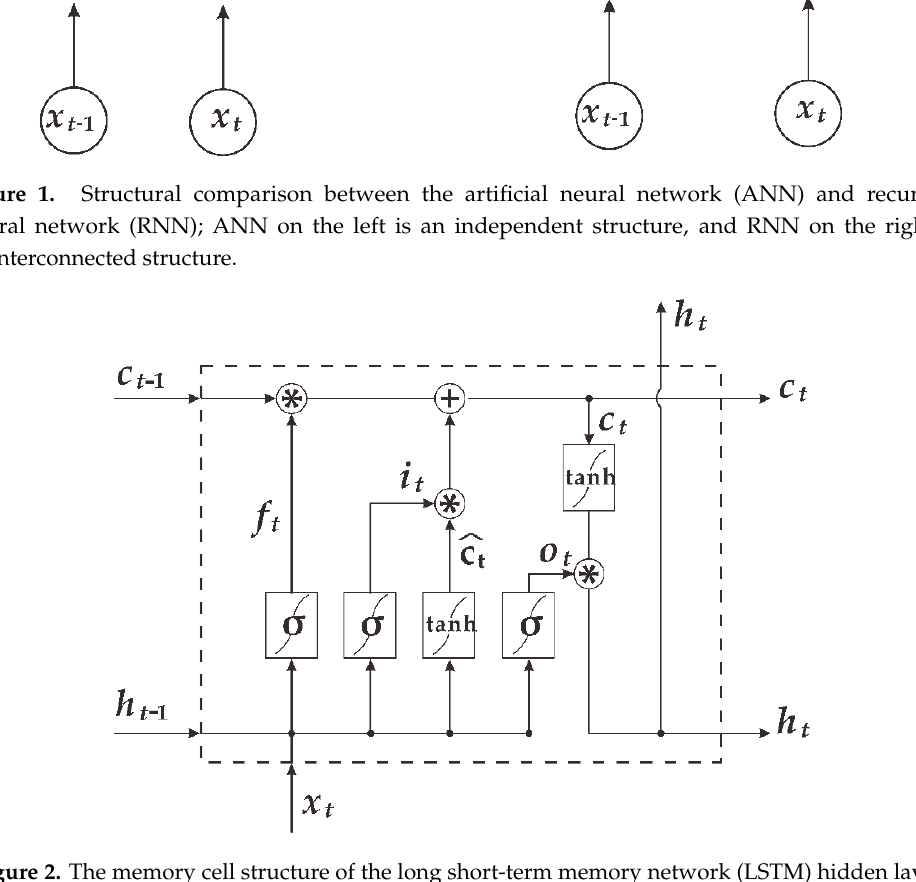
Figure 2. The memory cell structure of the long short-term memory network (LSTM) hidden layer.